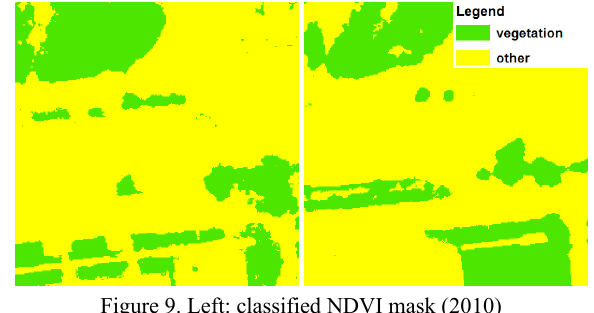
Figure 9. Left: classified NDVI mask (2010) Right: classified NDVI mask